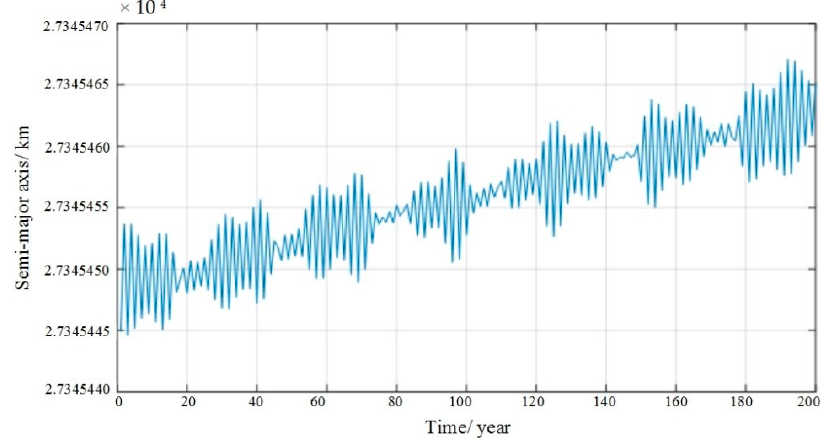
Figure 20. Variations in the semimajor axis of the optimal disposal orbit.